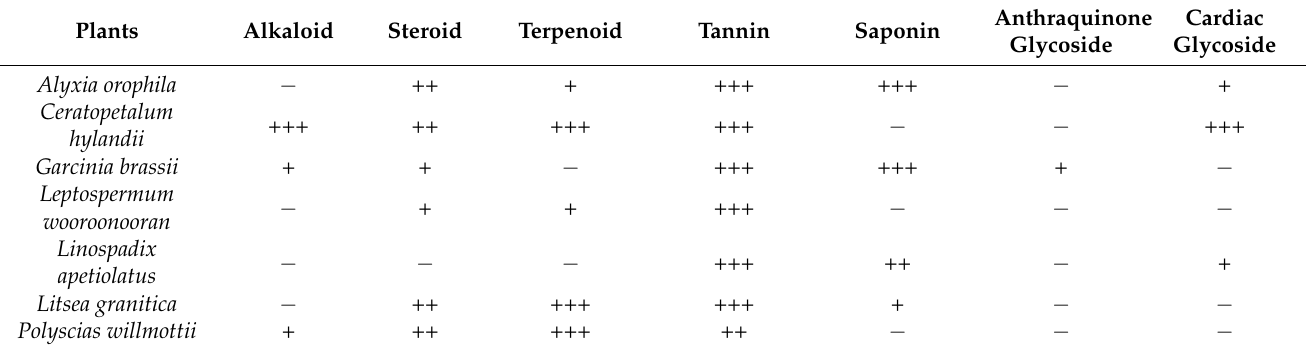
Table 2. Wet Tropics’ plant extracts showing positive tests for major classes of